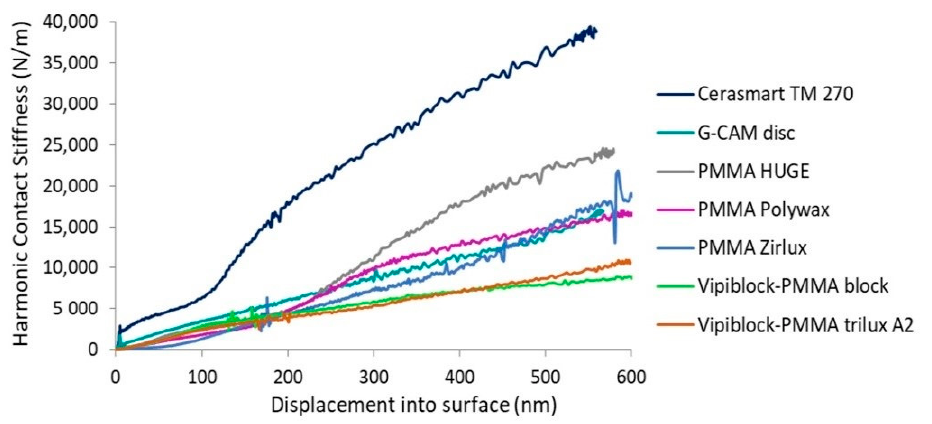
Figure 4. Harmonic contact stiffness as function of displacement of the investigated CAD/CAM restorations under nanoindentation experiments.